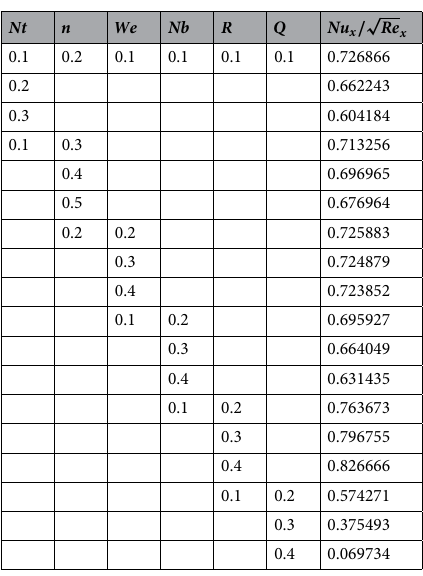
Table 3. Variation of Nu x / √ Re x when M = 0.2, S = 0.5, R = 0.2, Pr = 2, Nb = 0.1, Du = 0.2,